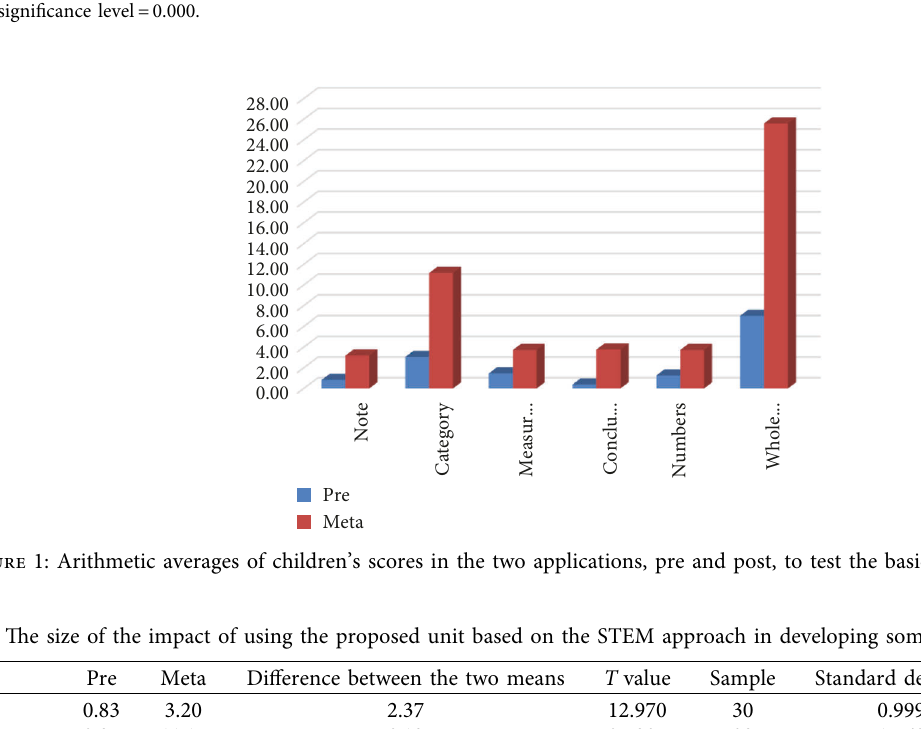
Measurement Conclusion